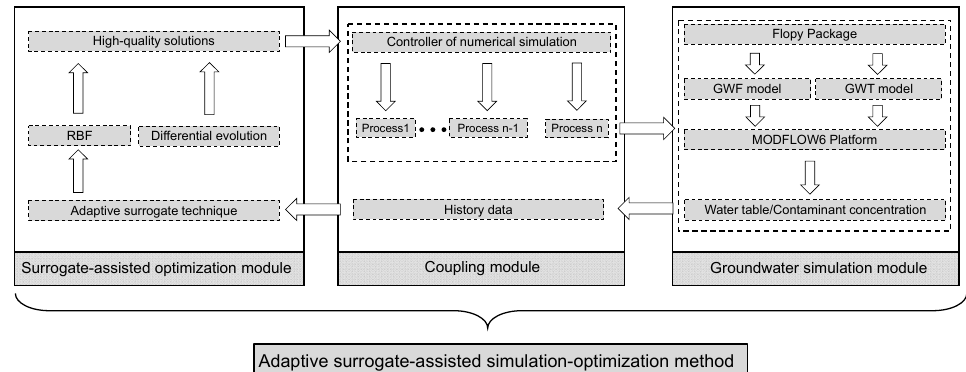
Figure 3. The procedure framework of the proposed method.